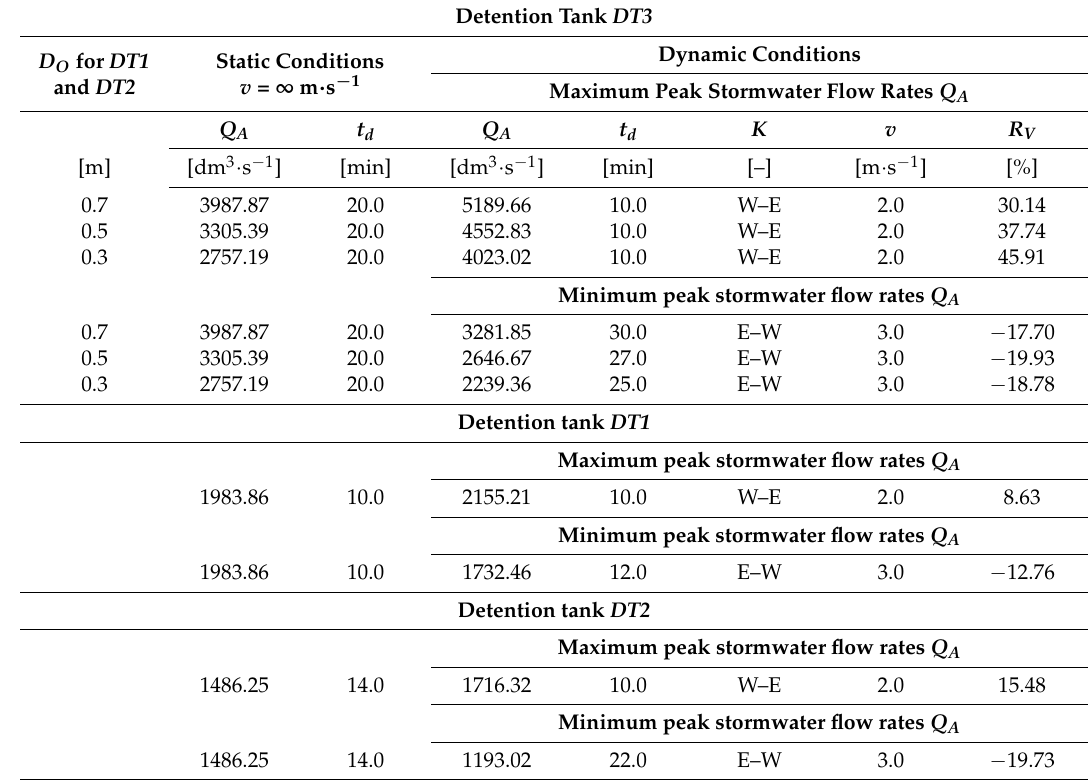
Table 1. Maximum peak flow of stormwater Q A for the storage reservoir at the assumed